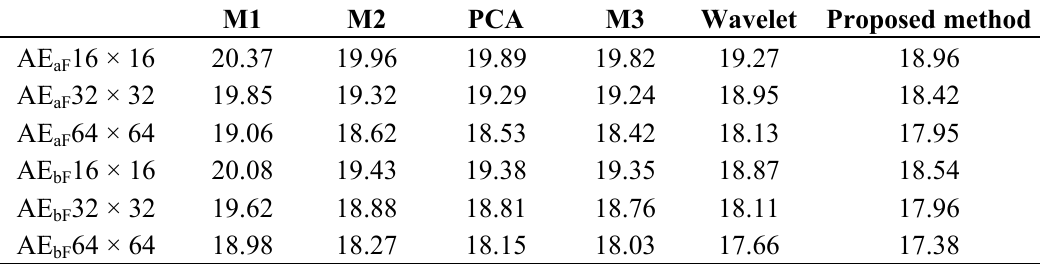
he criteria, M1–M3 and M3 and PCA 3.3%, 0.6% ndices indic method mea